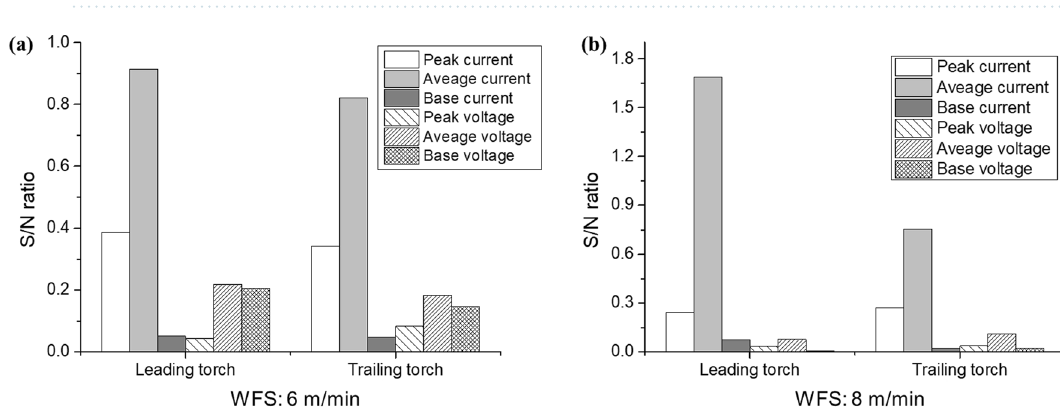
Figure 6. S/N ratio analysis for seam tracking signal selection for wire feeding speed (WFS) of ( a ) 6 m/min and ( b ) 8